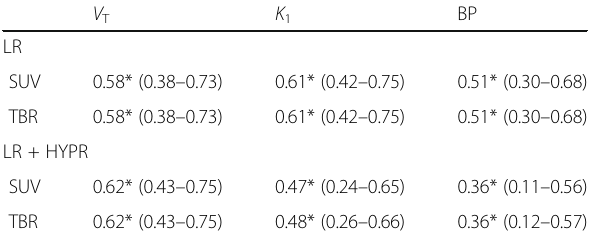
Table 3 Correlation (Spearman, with 95% confidence intervals) between PVC-induced relative changes in kinetic parameter estimates and simplified